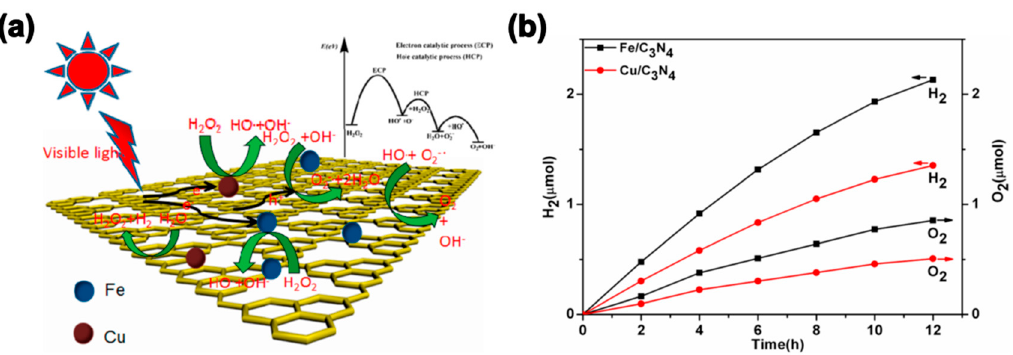
Figure 9. ( a ) A schematic diagram of the water splitting mechanism by Fe / C 3 N 4 and Cu / C 3 N 4 photocatalysts under visible-light irradiation. ( b ) Production of H 2 and O 2 by water splitting by the Fe / C 3 N 4 and Cu / C 3 N 4 photocatalysts under visible-light irradiation for 12 h. Reproduced with permission from [84]; copyright (2015), American Chemical Society.